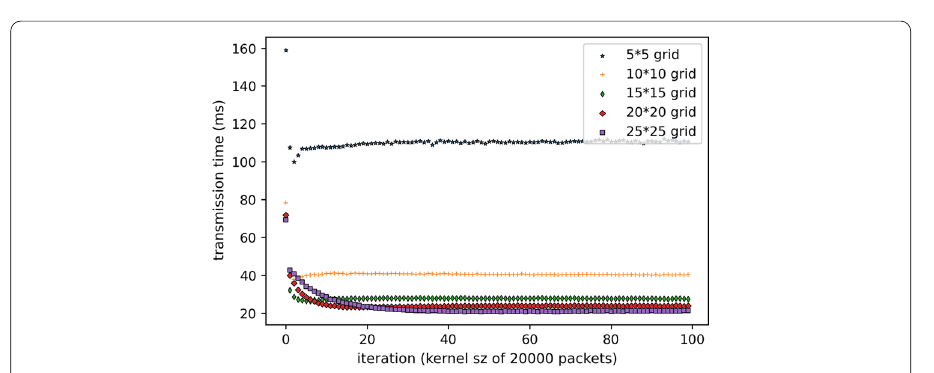
Fig. 10 Modified algorithm under different topologies